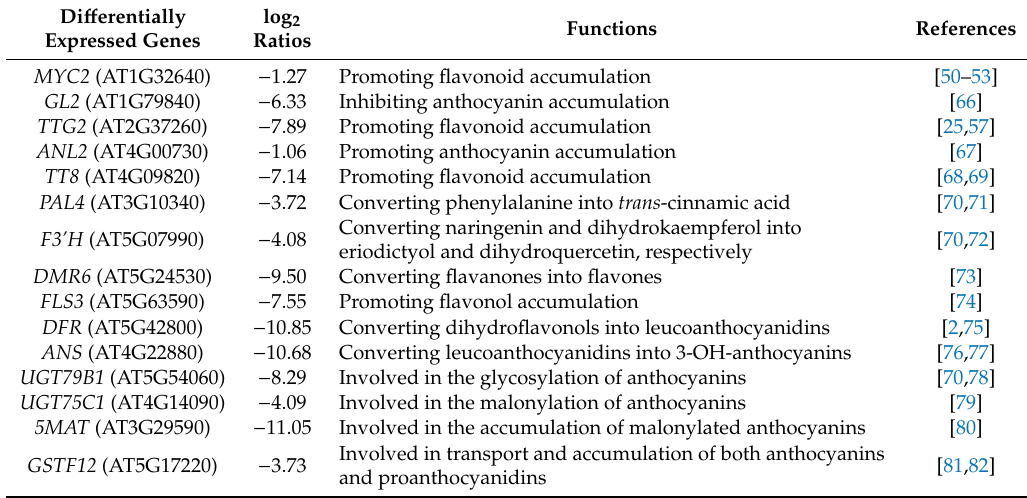
Table 2. Di ff erentially expressed genes (DEGs) contributing to flavonoid biosynthesis in the young shoots and expanding true leaves of ttg1-13 plants at 20 days after germination. DEGs with | log 2 ratios | ≥ 1.00, and only GO Slim IDs with FDR ≤ 0.05, are listed here. Di ff